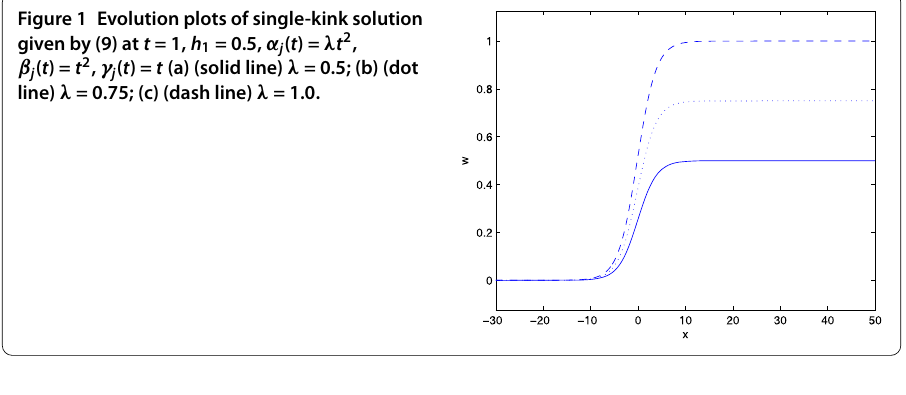
Figure 2 The profile figure for solution (12) with s 1 = 0.5, s 2 = 0.75, α j ( t ) = 8 t β j ( t ) = 4 t 5 (cid:6) (1.8)